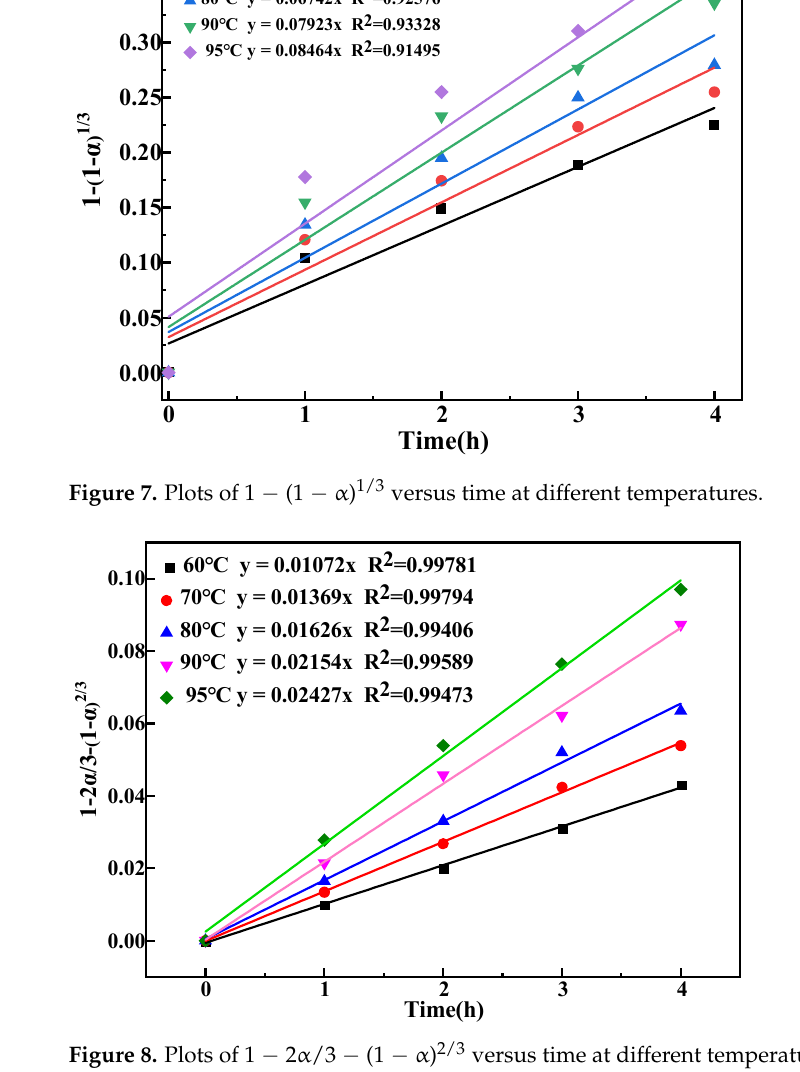
Figure 8. Plots of 1 − 2 α /3 − (1 − α ) 2/3 versus time at different temperatures.